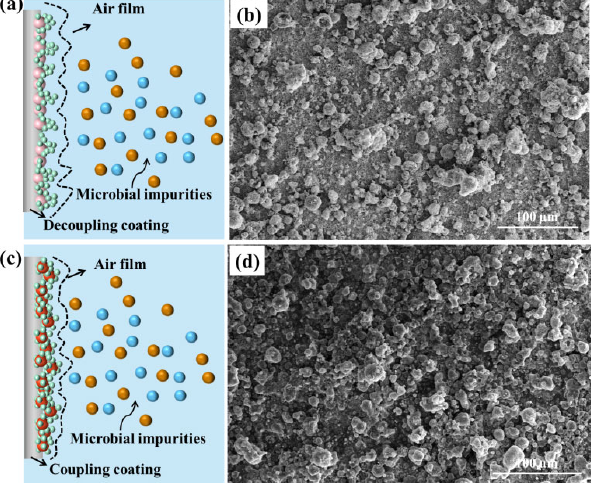
Fig. 14 Antifouling mechanism of (a) decoupling coating and (c) coupling coating; SEM images of (b) decoupling coating and (d) coupling coating after immersion into seawater for 7 d.